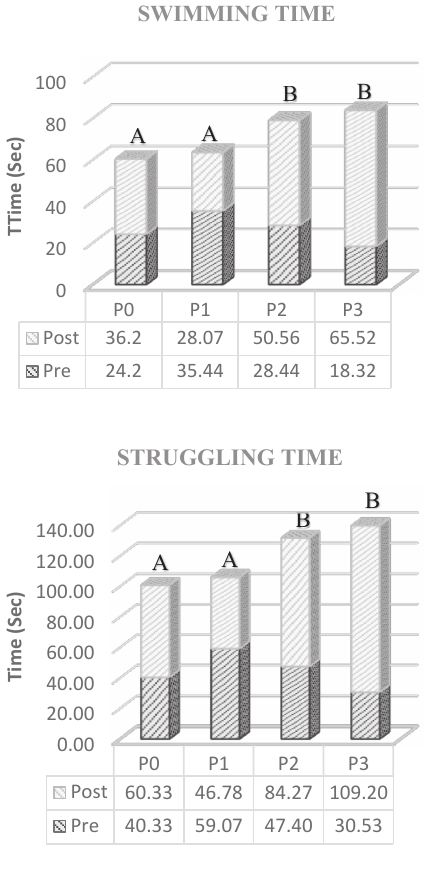
Figure 2. White tea intervention in the rats ’ struggling time (Different subset (A/B)meanstatistically difference p <